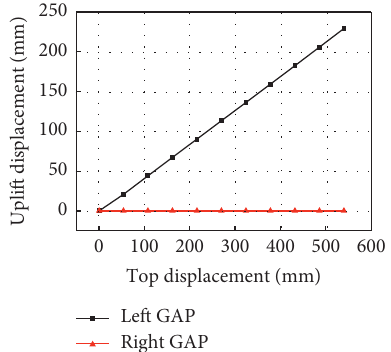
Figure 11: Uplift displacement versus top displacement of GAP.